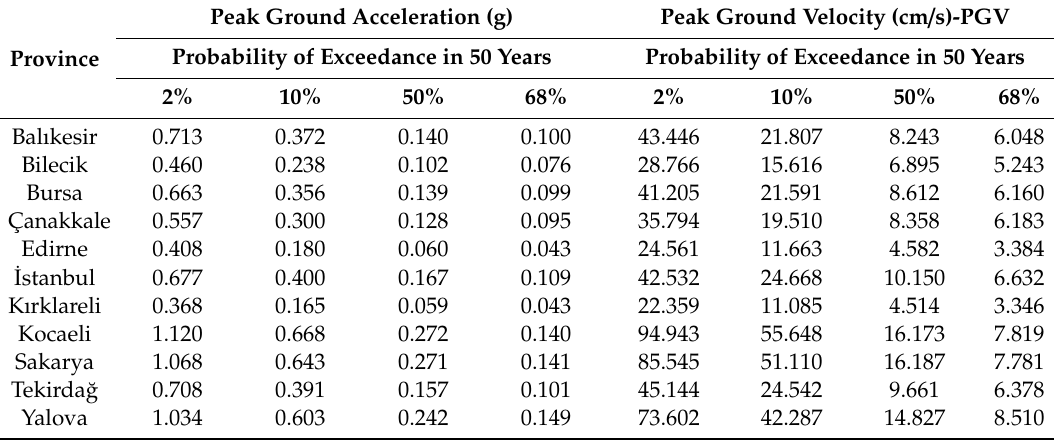
Table 2. Peak Ground Acceleration (PGA) and Peak Ground Velocity (PGV) values for di ff erent probabilities of exceedance in 50 years.